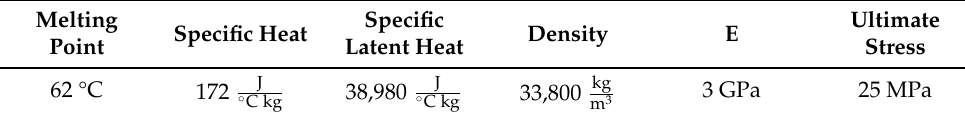
Table 1. Physical and mechanical properties of Field’s